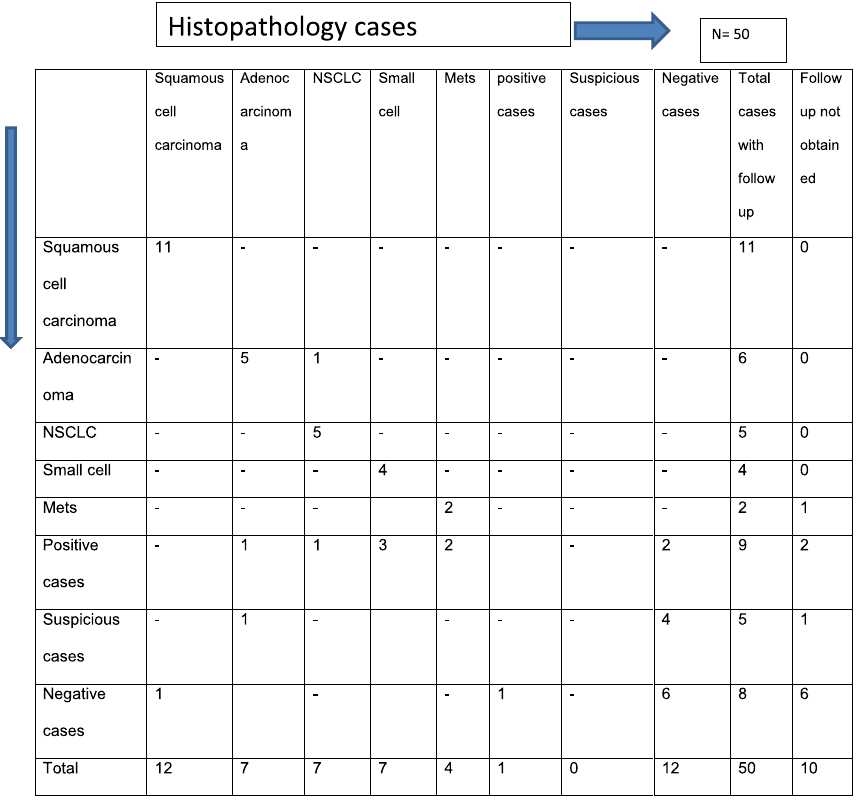
Table 4 Table showing correlation of squash smear cytology with histopathology